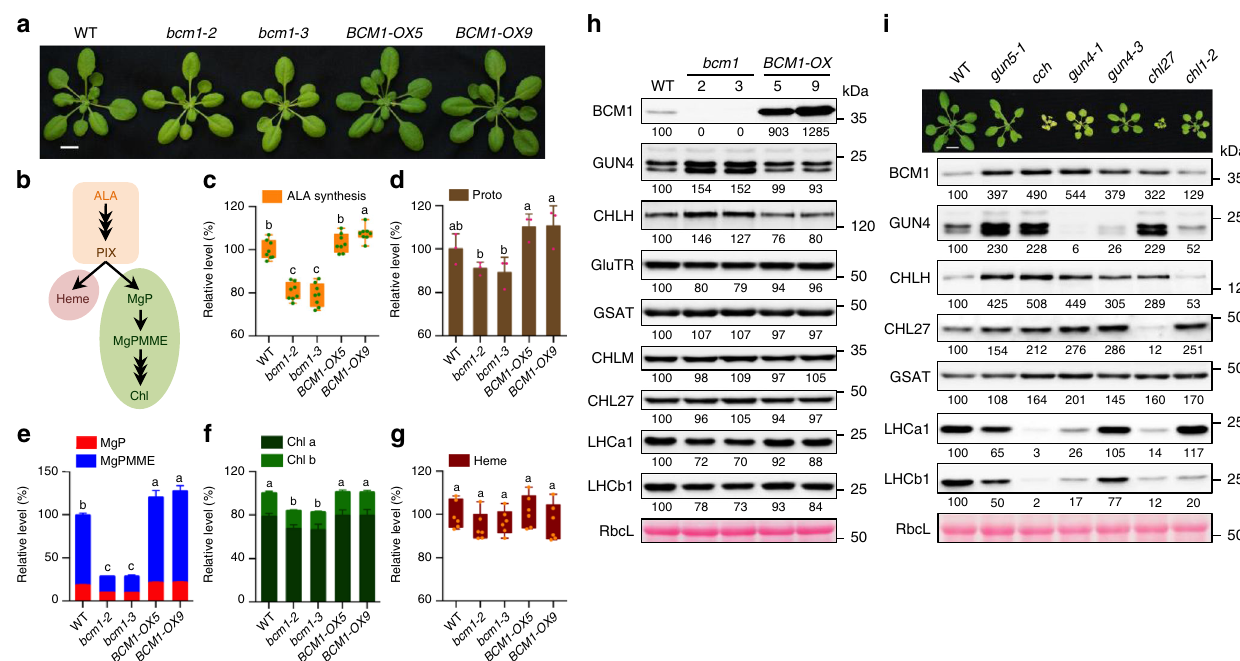
Fig. 2 BCM1 is a positive regulator of Chl biosynthesis in Arabidopsis . a Representative images of 28-day-old WT, bcm1 and BCM1-OX seedlings grown under short-day normal light (120 μ mol photon m − 2 s − 1 ) conditions. Scale bar, 1 cm. b Scheme of TBS in higher plants. c – g Relative ALA synthesis rate ( c ), Proto ( d ), Mg-porphyrin ( e ), Chl ( f ), and heme ( g ) levels in 18-day-old WT, bcm1 , and BCM1-OX seedlings grown under the same conditions as in a . Error bars represent SD of eight, three, four, twelve, and six biological replicates, respectively. Letters above histograms indicate signi fi cant differences as determined by Tukey ’ s HSD method ( P < 0.05). h Steady-state levels of the indicated proteins in seedlings analyzed in a were determined by immunoblot analysis using the indicated antibodies. i Steady-state levels of the indicated proteins in 28-day-old WT, gun5-1 , cch , gun4-1 , gun4-3 , chl27 , and ch1-2 representative image of the Arabidopsis seedlings analyzed in i is shown. In h , i , Ponceau S-stained membrane strips bearing RbcL were used as loading controls. Numbers below immunoblots represent normalized protein abundances relative to WT